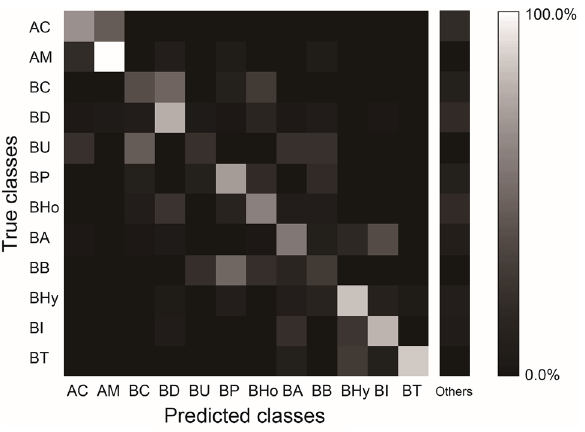
Figure 2. Confusion matrix by biologists. Bright color indicates high percentage of predicted classes for a true class. AC: Apis cerana , AM: A. mellifera , BC: Bombus consobrinus , BD: B. diversus , BU: B. ussurensis , BP: